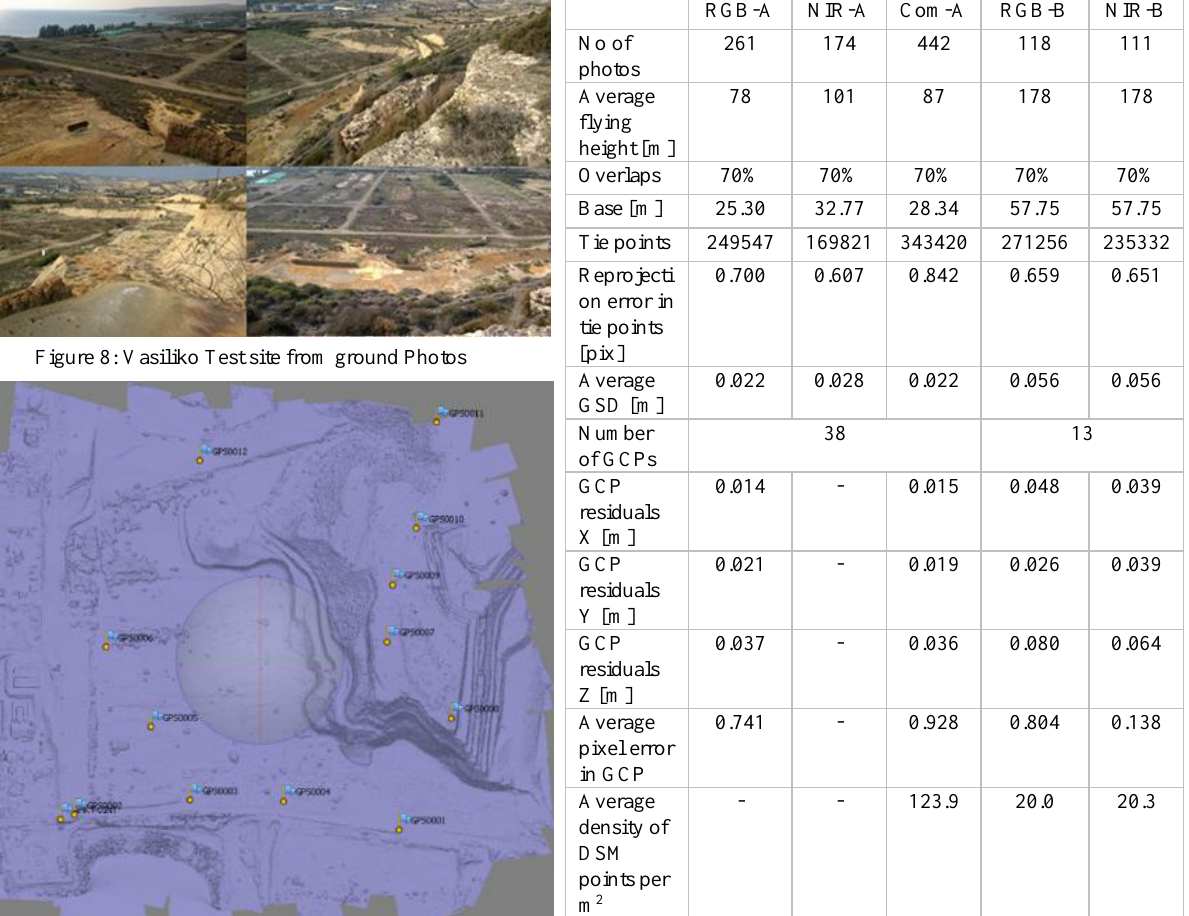
Table 1: RGB and NIR block processing results of both sites